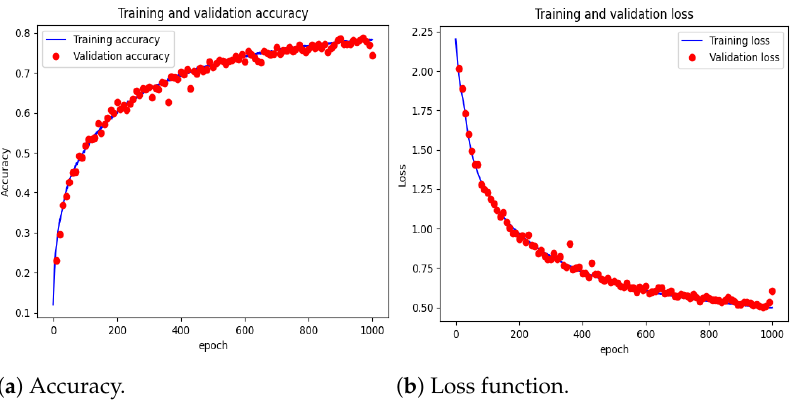
Figure 15a,b present the evolution of the cost function and the accuracy metric obtained during the classifier training procedure.